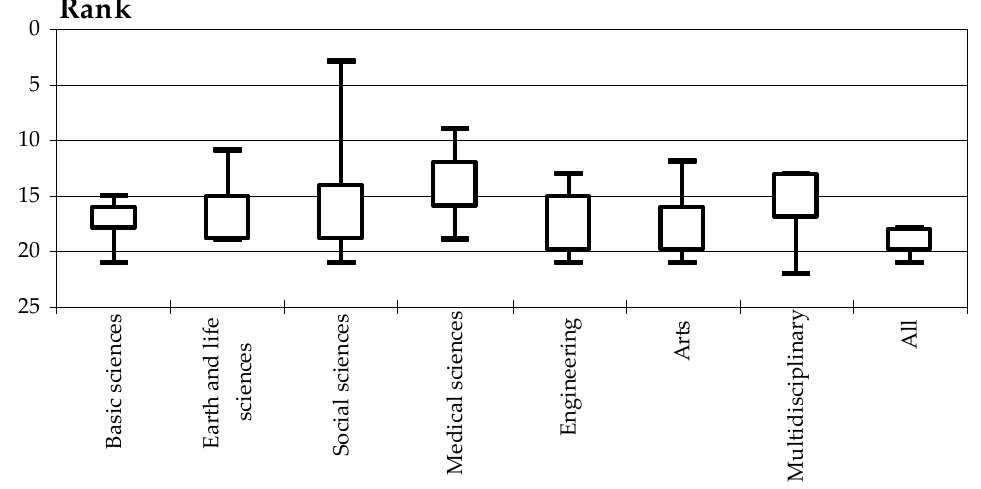
Figure 15. The visibility of articles published in aggregated research areas in Romania during 2010–2018, measured based on the adjusted number of citations per document. The figure displays boxplots based on the ranks of the aggregated research areas computed for each year separately. The results indicate the variability across the research areas and a poorer overall performance.